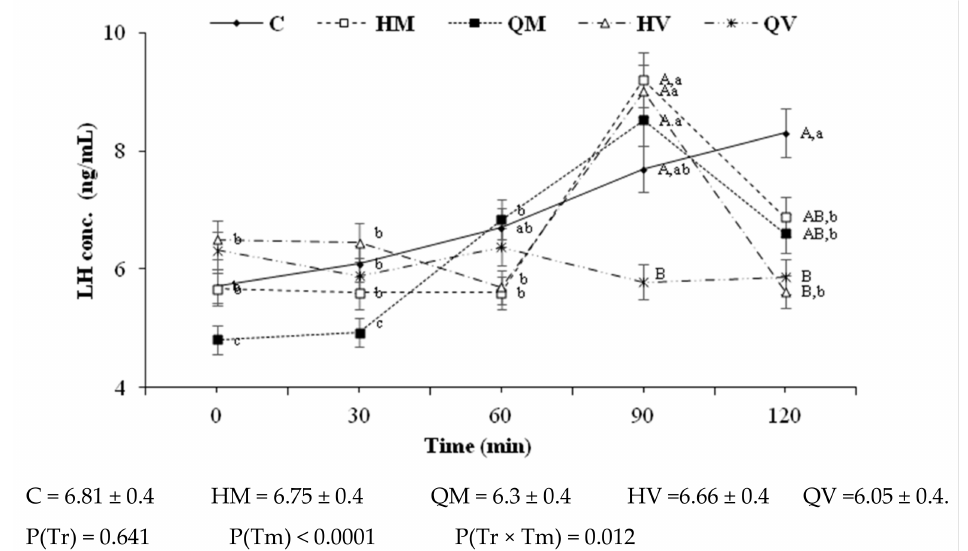
Figure 6. Changes over time in mean ( ± S.E.M.) serum LH concentrations in rabbit does receiving two i.m. doses (HM = 0.4 µ g and QM = 0.2 µ g) or two intravaginal doses (HV = 4 µ g and QV = 2 µ g) of GnRH–ChNPs or bare GnRH (C = 0.8 µ g). Overall values are included below the figure. P(Tr) accounts for treatment effects, P(Tm) for time effects, and P(Tr × Tm) for their interactions. Different uppercase and lowercase superscript letters denote significant differences ( p < 0.05) between or within treatments, respectively.